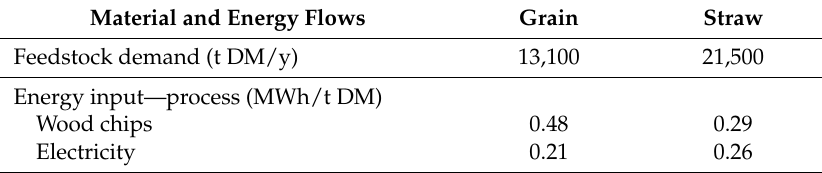
Table 3. Material and energy flows in the production of biogas from wheat grain and straw